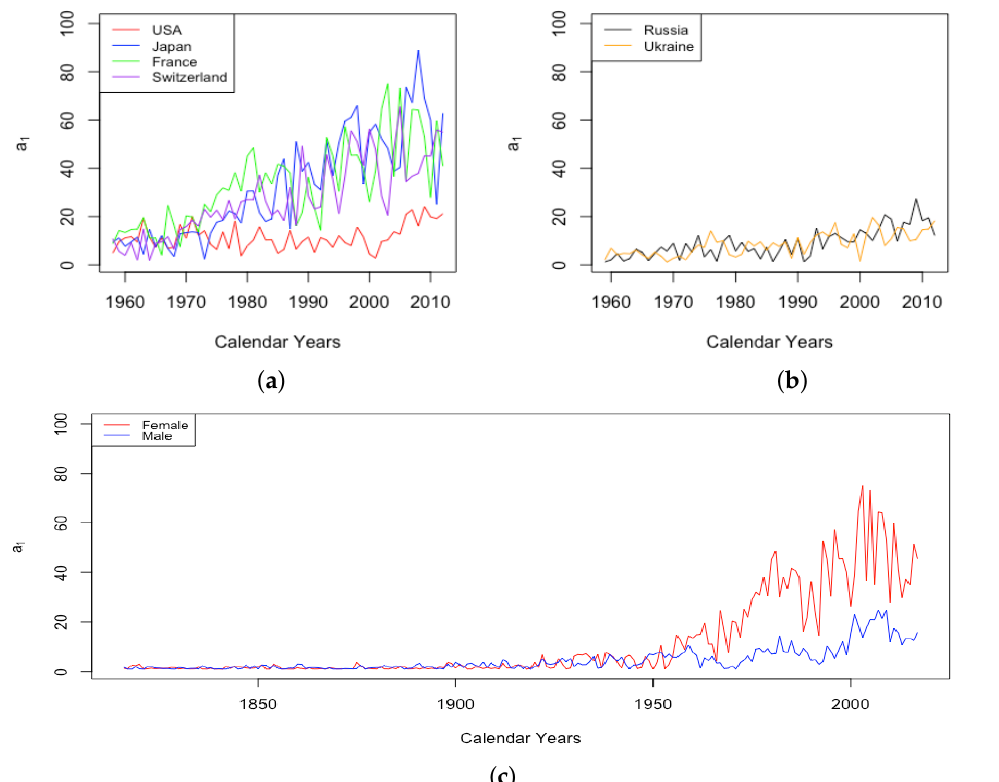
Figure 13. ( a ) Mortality deceleration level a 1 before age 65 across HLE countries. ( b ) Mortality deceleration level a 1 before age 65 across ILE countries. ( c ) Mortality deceleration level a 1 before age 65 for France, male vs.